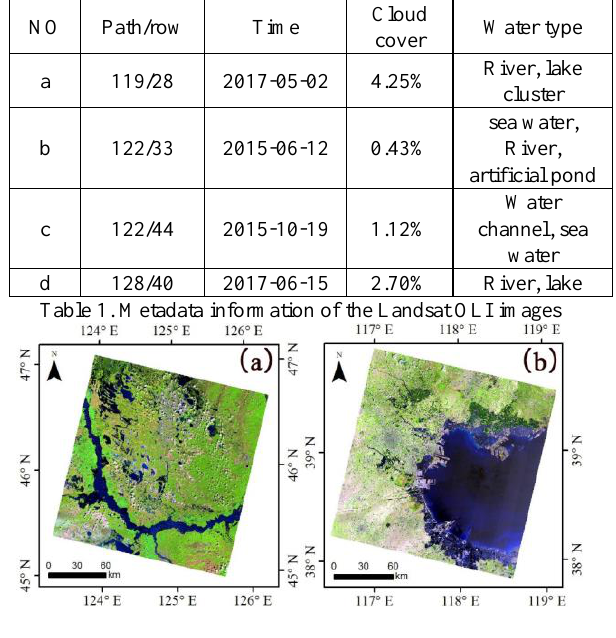
Table 1. Metadata information of the Landsat OLI